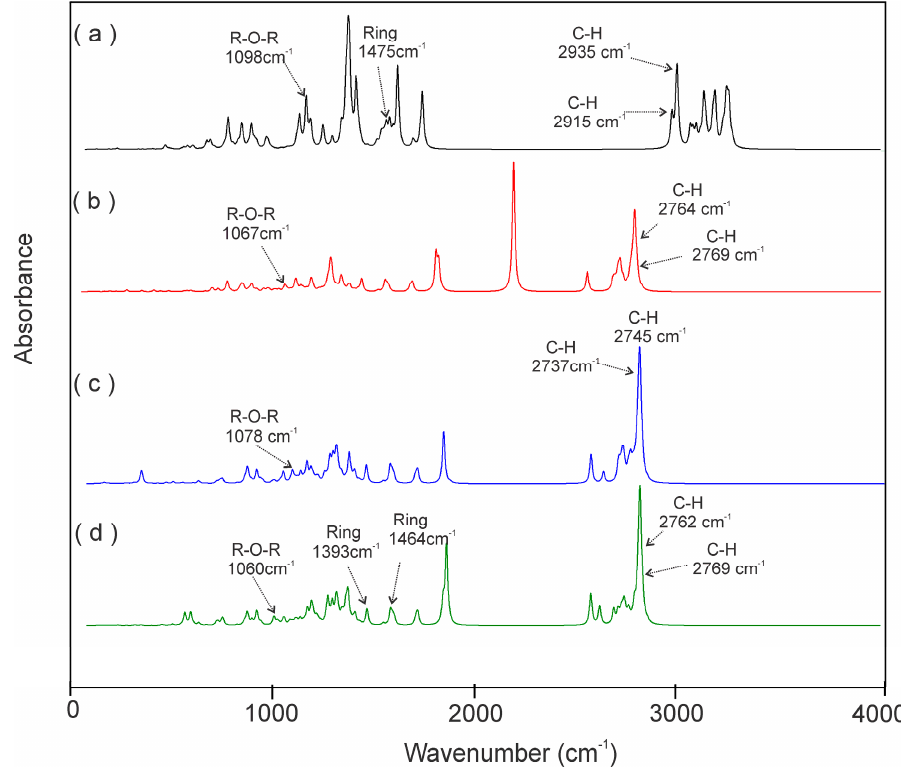
Figure 5. Infrared (IR) spectra of ( a ) TAM; ( b ) ND2HP-TAM complex (PM6); ( c ) NDPEG-TAM complex; and ( d ) NDPGA-TAM complex.